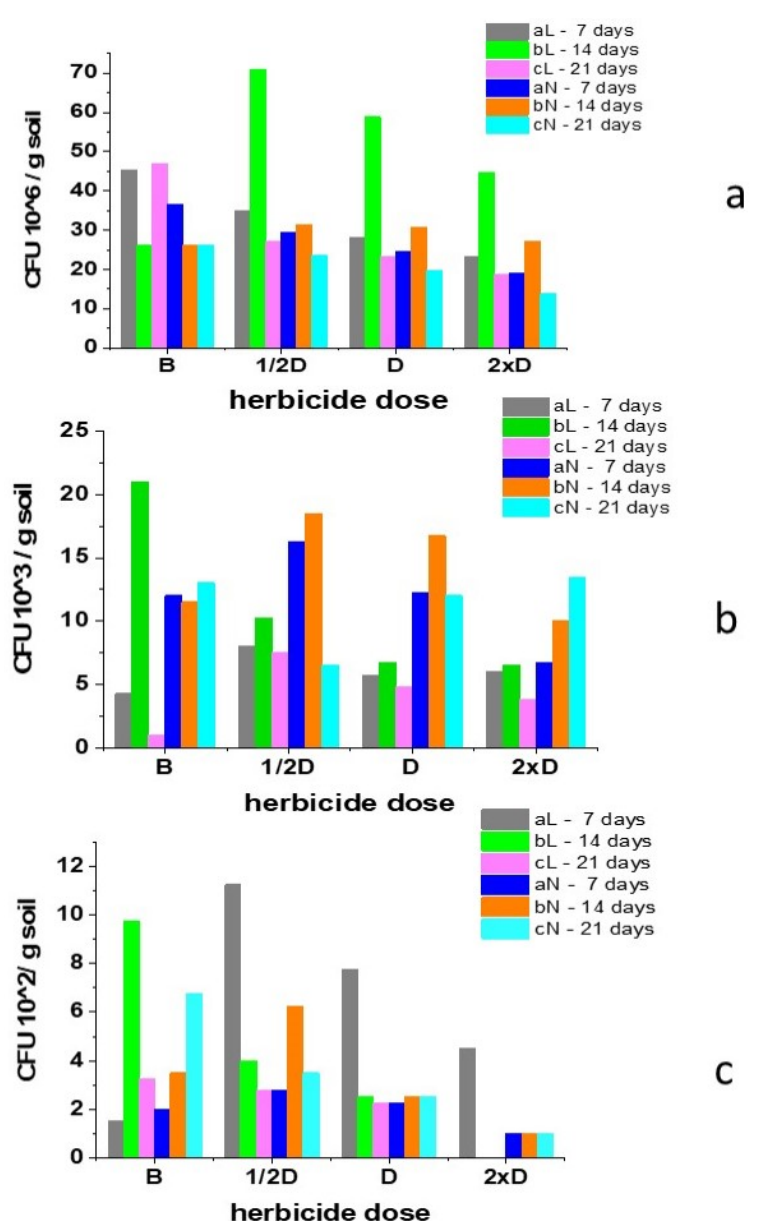
Figure 3. Variation of soil population of the bacteria ( a ), molds ( b ) and yeasts ( c ) for the various doses of oxyfluorfen (B—samples untreated with oxyfluorfen, ½ D—a half of the normal dose, D—normal dose, 2× D—double dose) and in relation to the exposure periods.